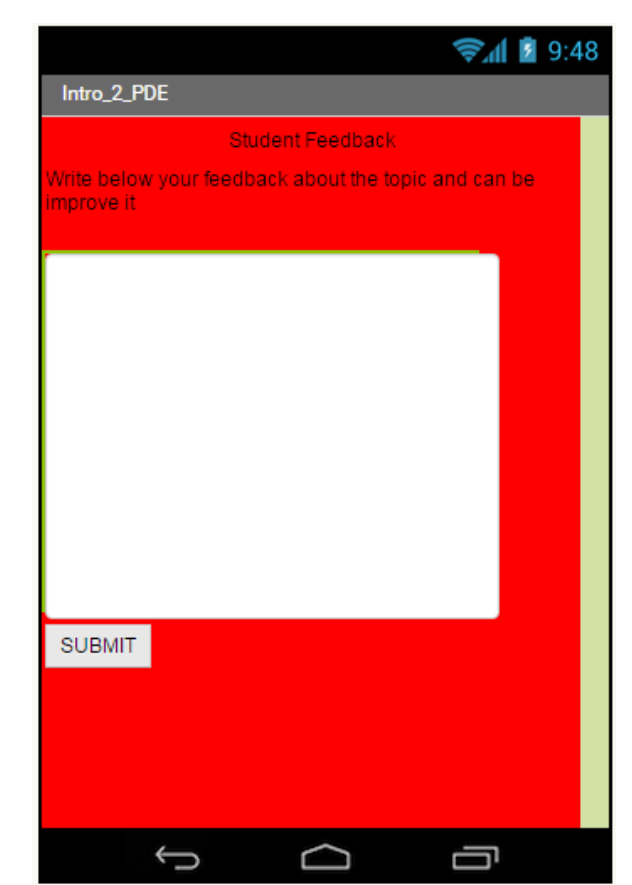
Fig. 10. Blocks screen of the student